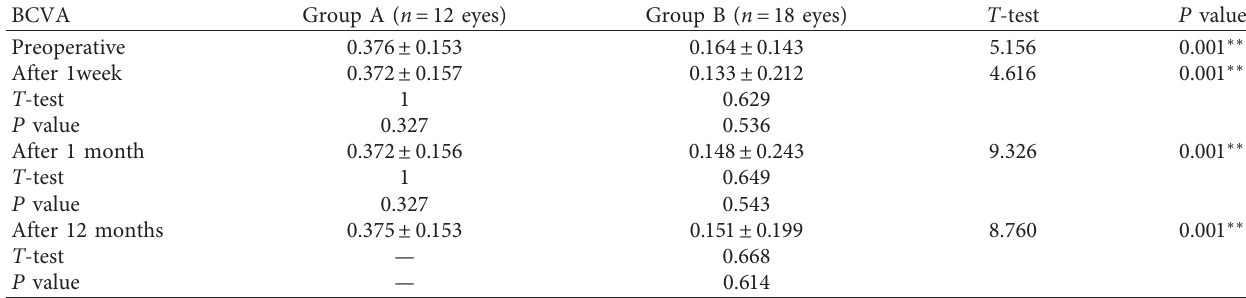
Table 4: Comparison between the two groups as regarding postoperative BCVA.